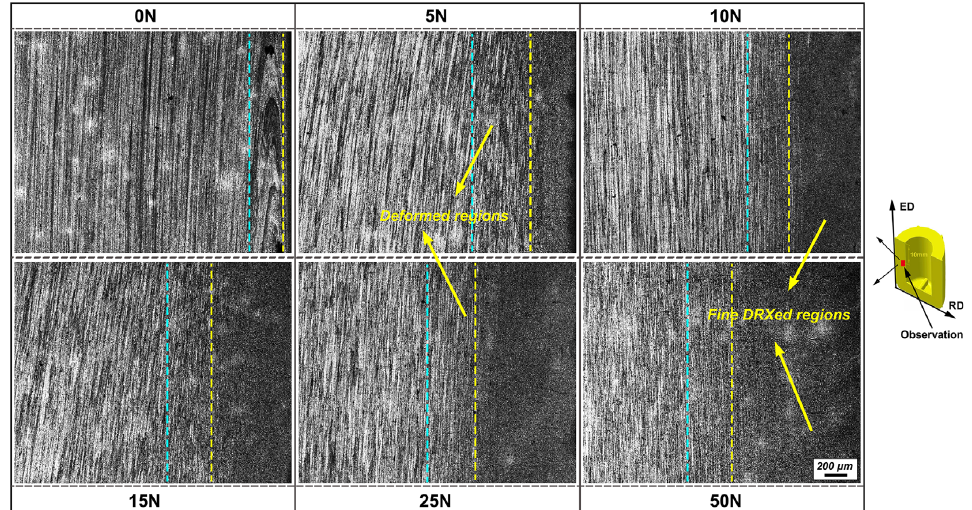
Figure 8. OM images of the inner wall region of extruded samples selected from different N.